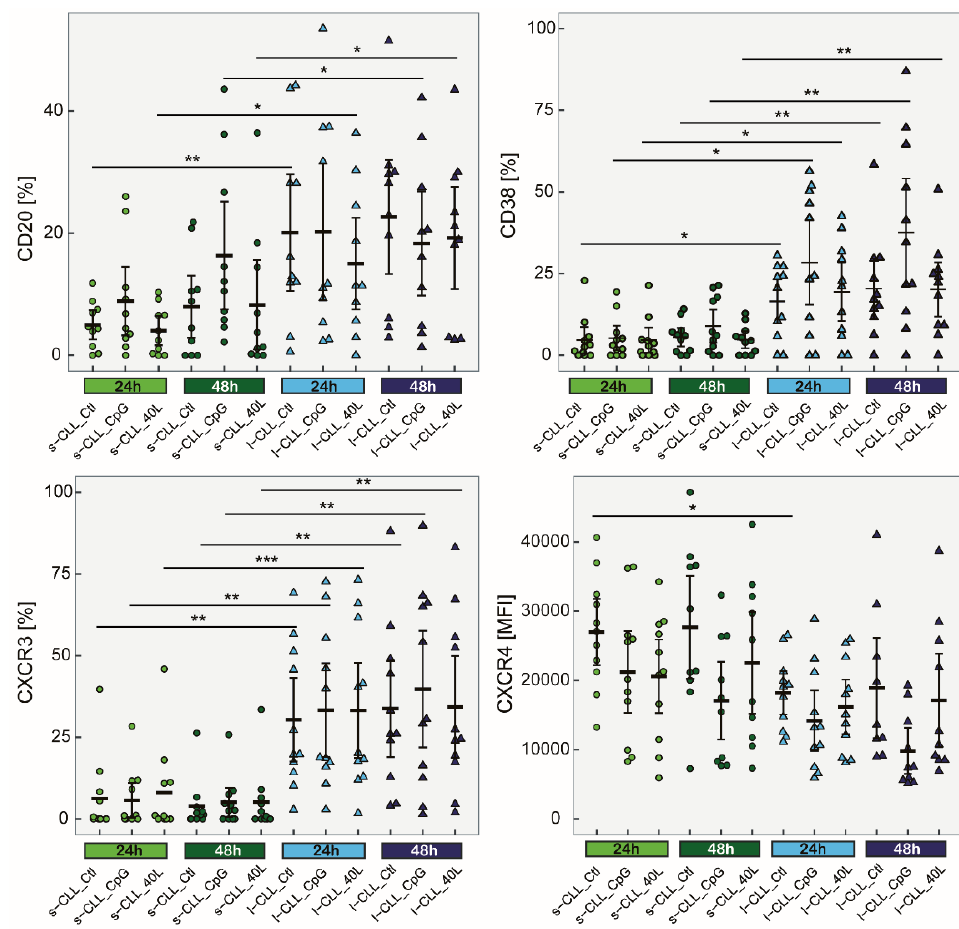
Figure 5. The immunophenotypes of sorted s-CLL vs. l-CLL cells cultured for 24 and 48 h with CpG and CD40L; CXCR4 MFI and the percentage of CXCR3, CD20 and CD38 on cultured CLL cells ( n = 11). * p < 0.05, ** p < 0.01, *** p < 0.001.